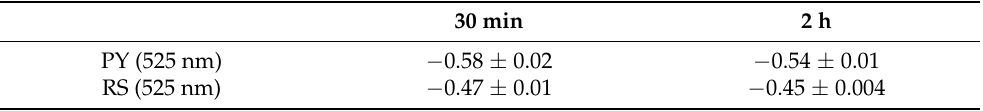
Table 2. Antioxidant activity, as measured by a reduction in absorbance at 525 nm corresponding to a discoloration of 2,2-diphenyl-1-picrylhydrazyl (DPPH) solutions in contact with OB, OB@5%RS and OB@5%PY